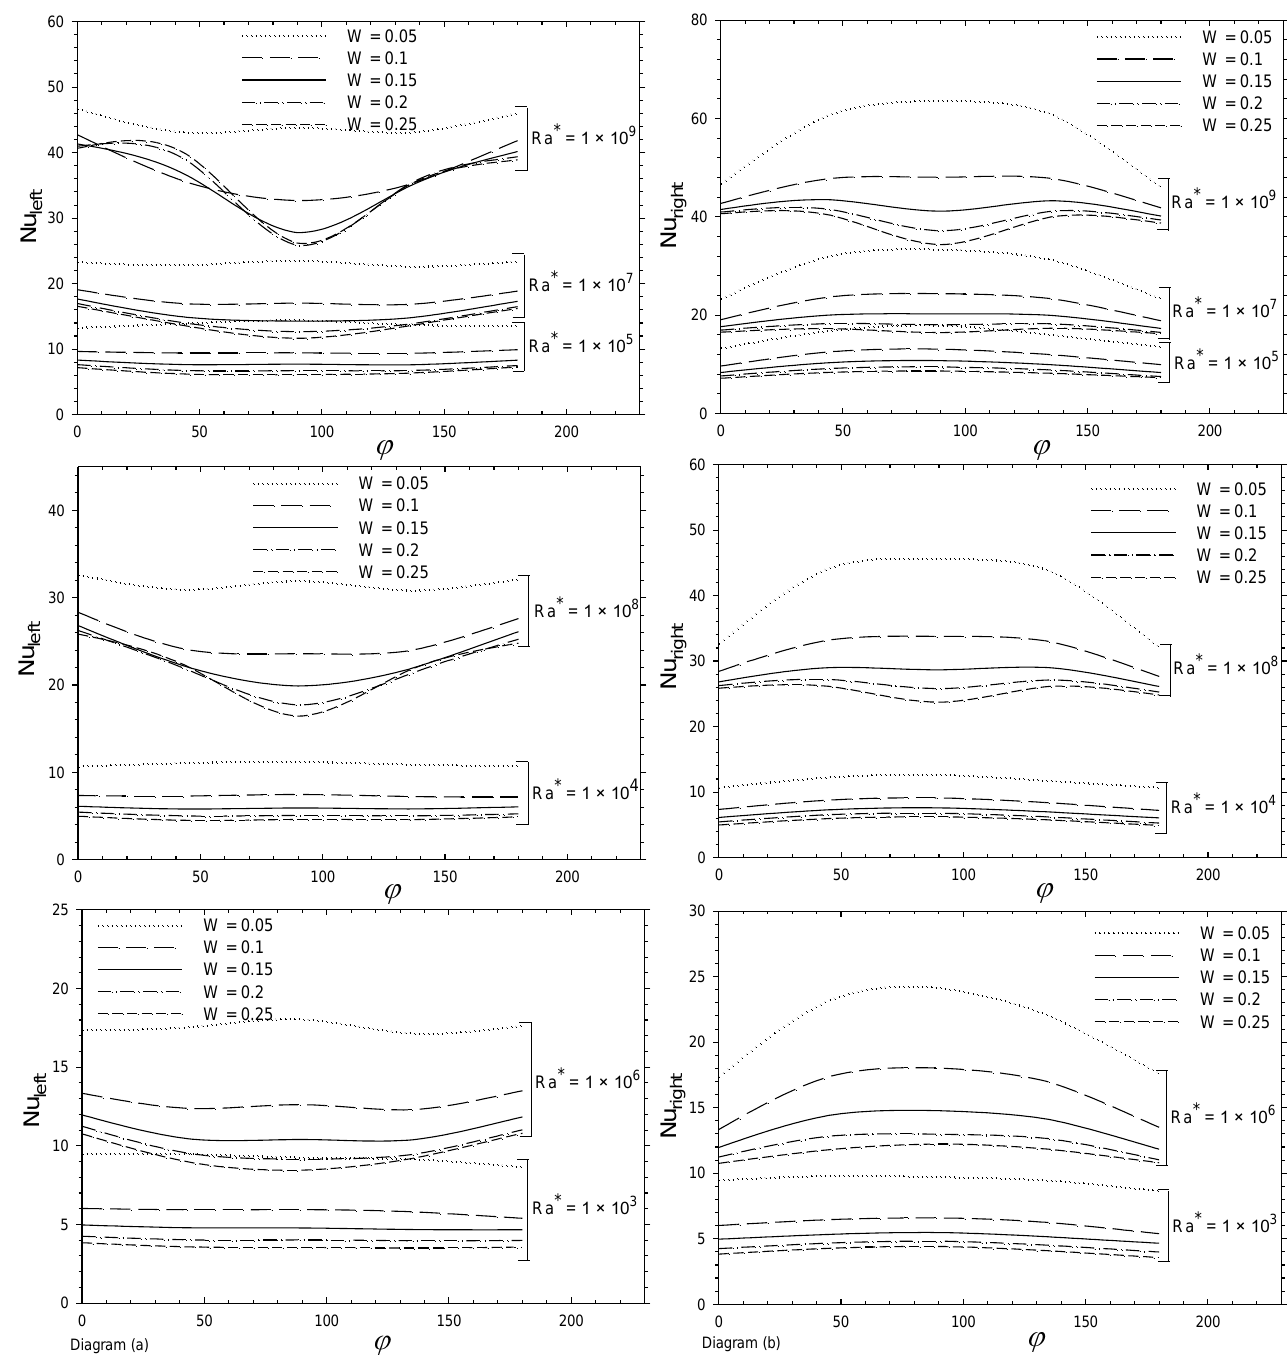
Figure 13. Variations in the mean Nusselt number for the left-side and right-side surfaces of a slender cuboid with inclination ϕ for different Ra * and W for ( a ) left-side and ( b ) right-side surfaces.